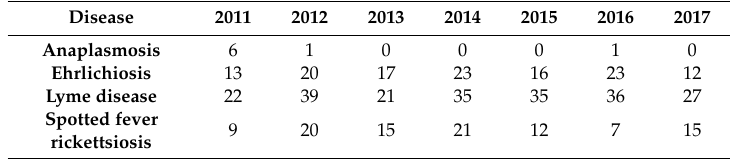
Table 1. Acquired cases of tick-borne diseases in Florida. Includes confirmed and probable cases (Florida Department of Health, Morbidity and Mortality Report